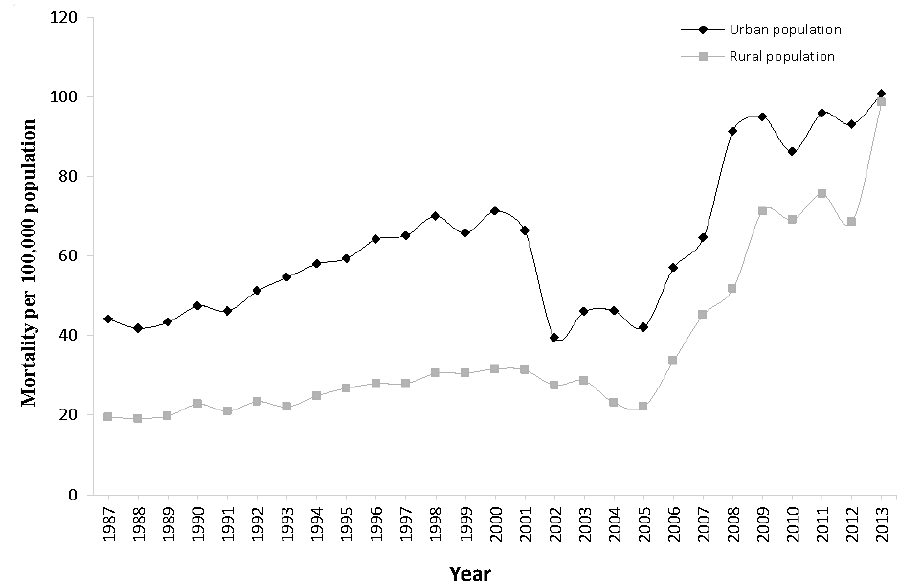
Figure 1. Ischemic heart disease (IHD) mortality rates trend in urban and rural China, 1987–2013.